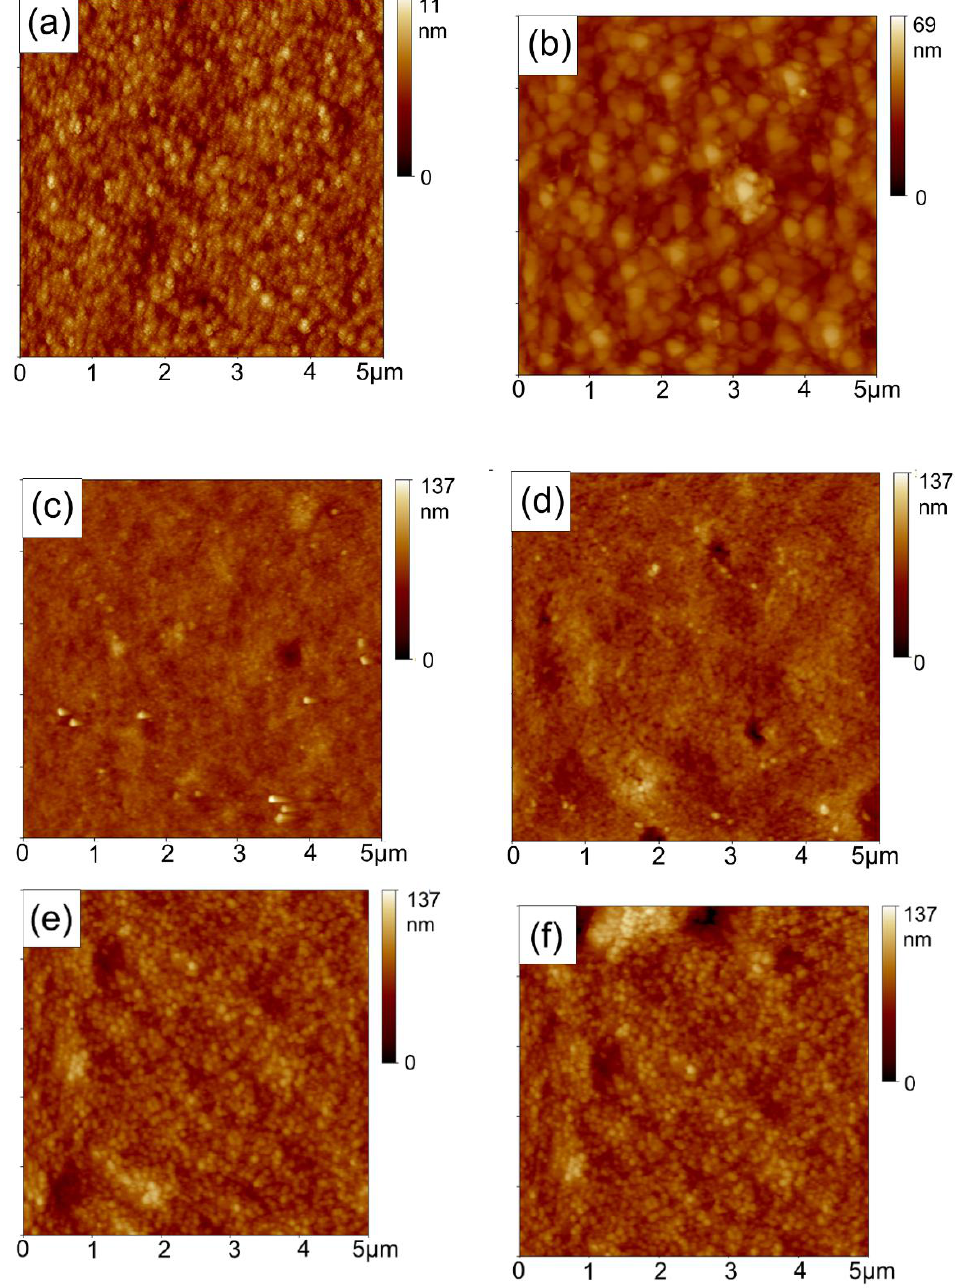
Figure 3. Atomic force microscopy (AFM) images of ( a ) ITO/ZnO thin film; ( b ) ITO/ZnO/CdSe thin film; and ITO/ZnO/CdSe/CdTe with annealing temperatures of ( c ) 250; ( d ) 290; ( e ) 310; and ( f ) 380 °C.